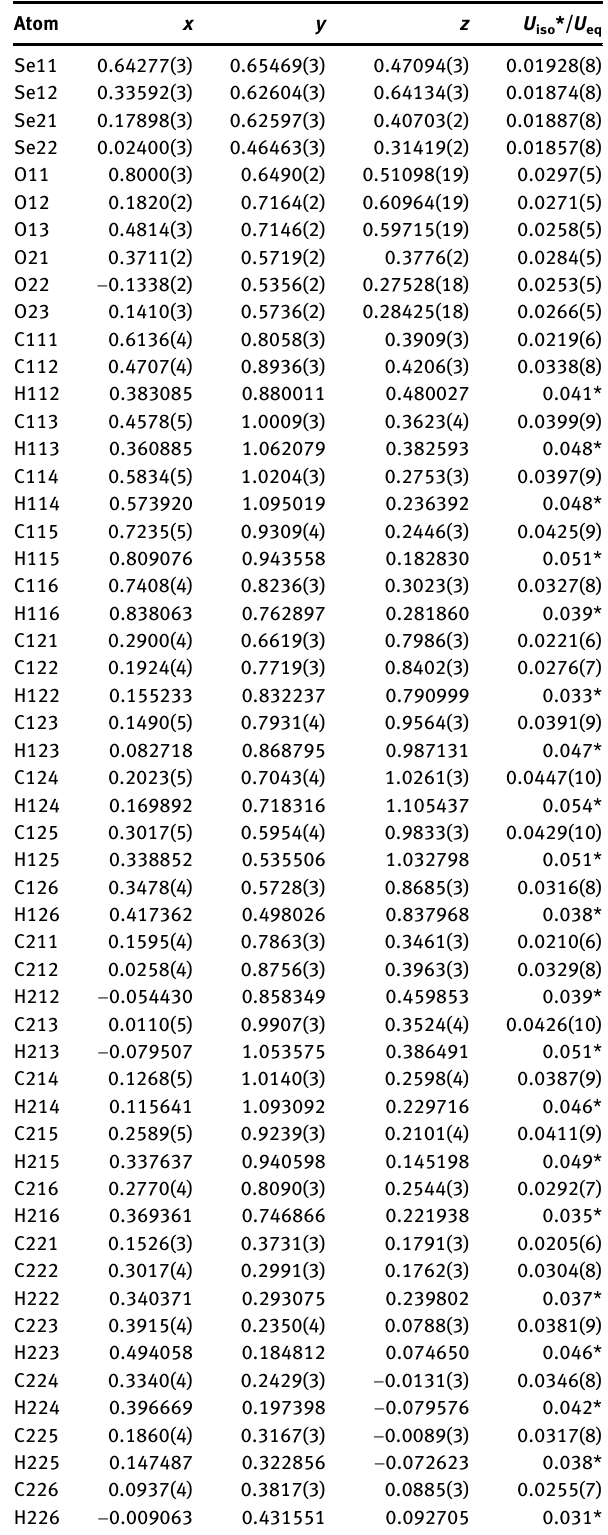
isotropic displacement parameters (Å 